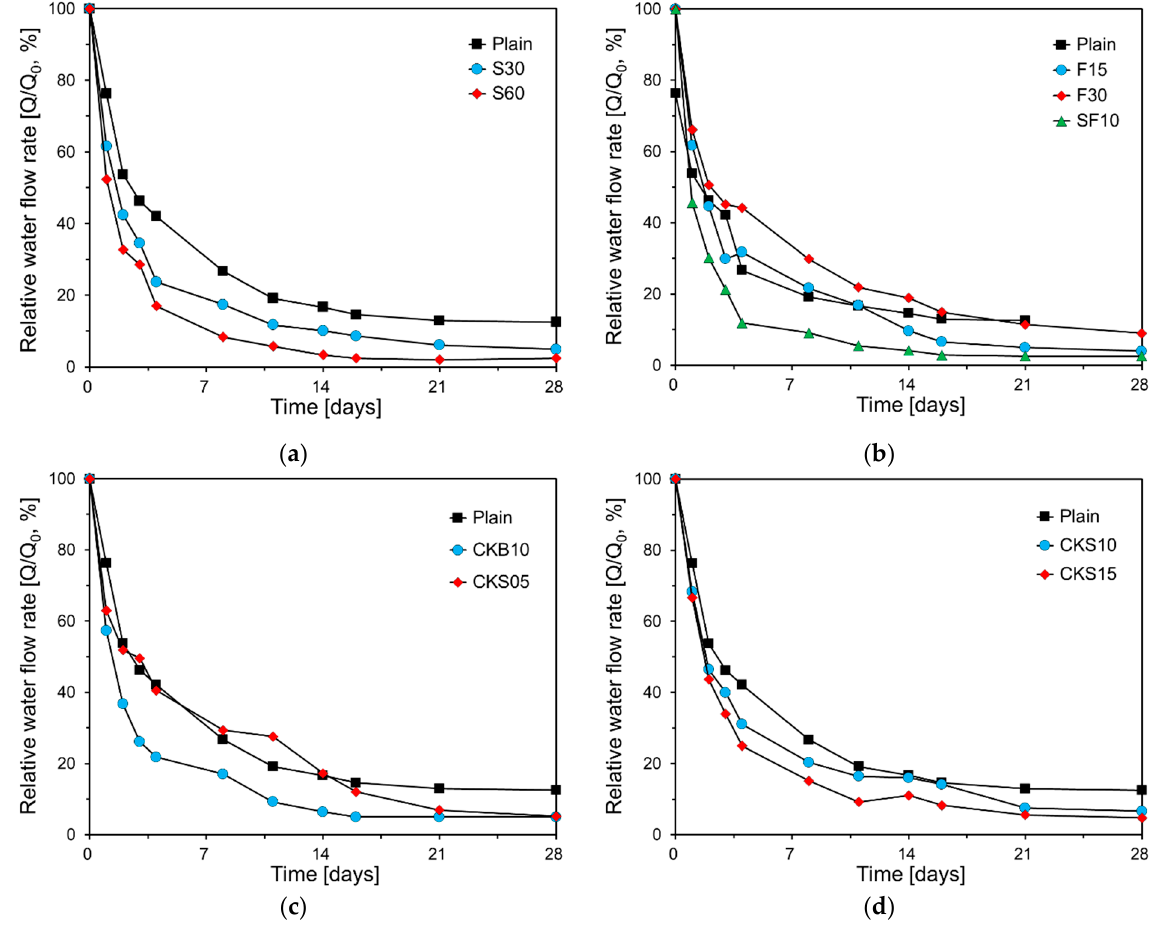
Figure 9. Water flow test results: ( a ) Plain, S30, S60; ( b ) Plain, F15, F30, SF10; ( c ) Plain, CKB10, CKS05; ( d ) Plain, CKS10, CKS15.